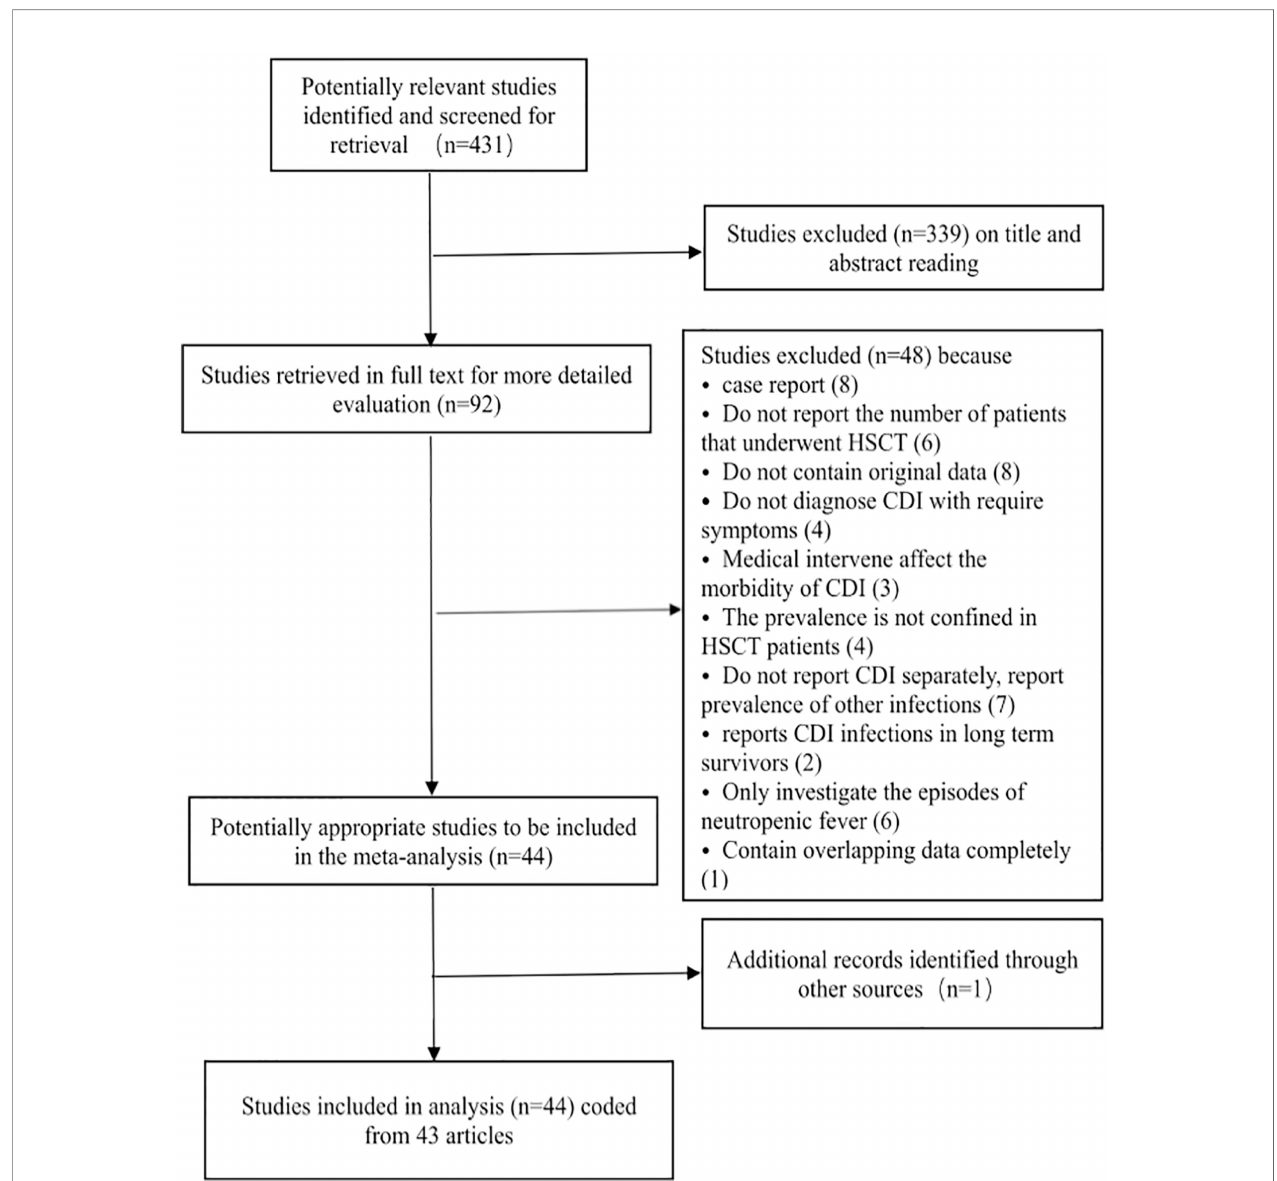
FIGURE 1 | Flowchart of the